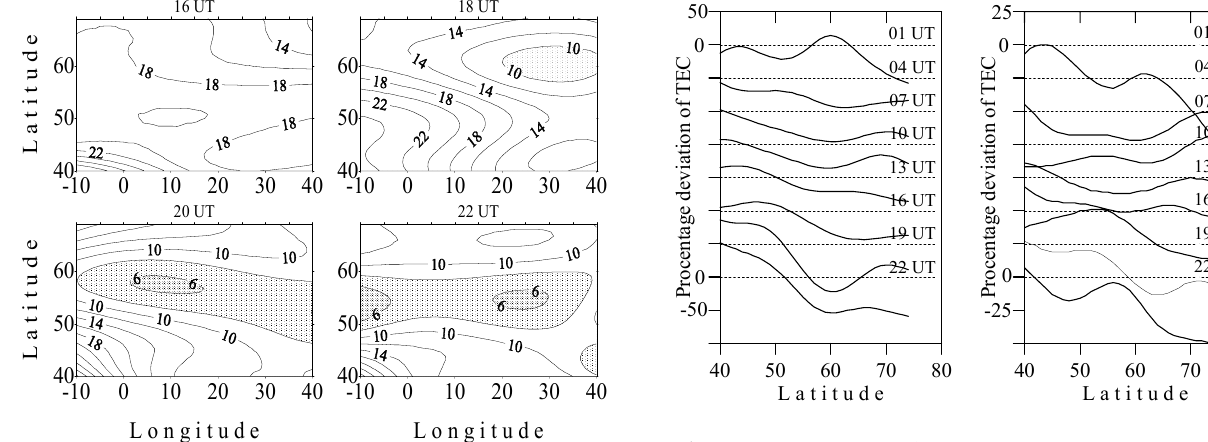
Fig. 8. Latitude profiles of TEC changes relative to the quiet time for 13 September (left panel) and 14 September (right panel) at dif- ferent hours. Each curve is shifted downwards by 50% in left panel and by 25% in the right one.